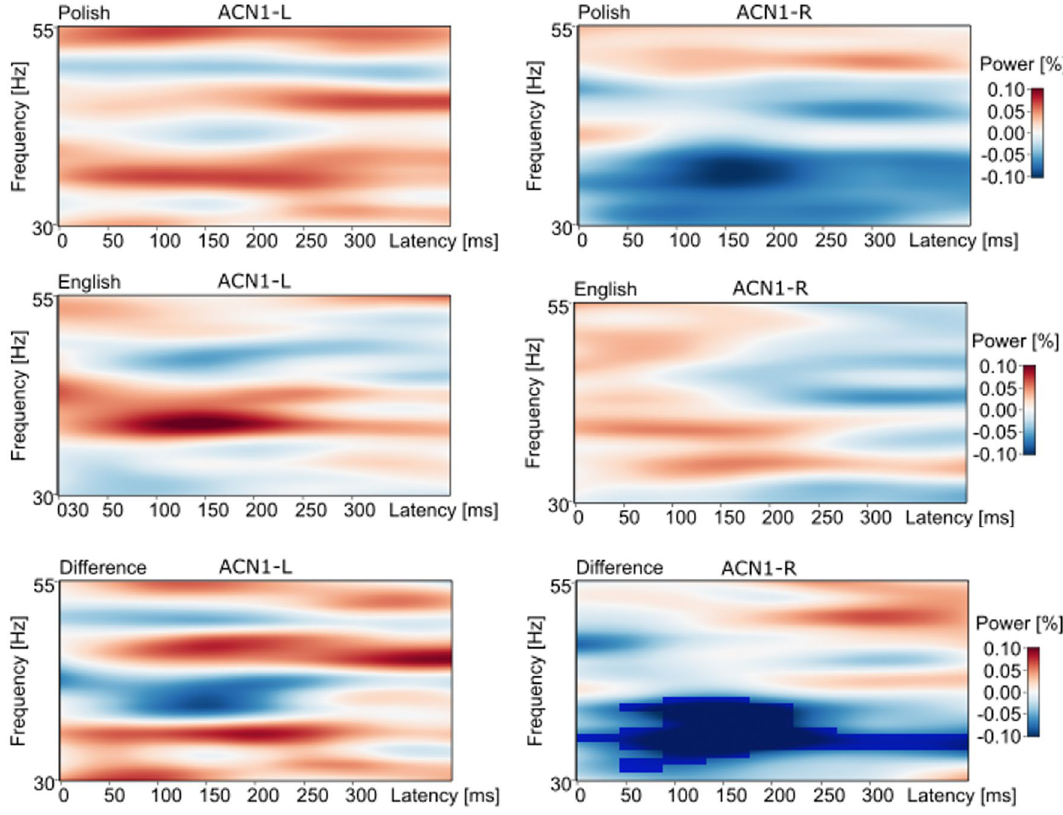
Figure 3. Language-group effects to /pt/ onsets, passive condition. Figure illustrates spectral power (TSE) values for the Polish and English groups from the bilateral auditory source-level channels ACN1-L (left) and ACN1-R (right) in response to the /pt/ onsets, for the passive condition. Significantly larger TSE values were found for the English compared to the Polish listeners to the /pt/ onsets from the right hemisphere source-level channel (ACN1-R) (p = 0.035, 31–40 Hz, 0–400 ms), with blue masking (bottom row, right column) depicting the time–frequency interval for the significant effect. TSE values did not differ for the language groups to the / pt/ onsets from the left hemisphere (p =